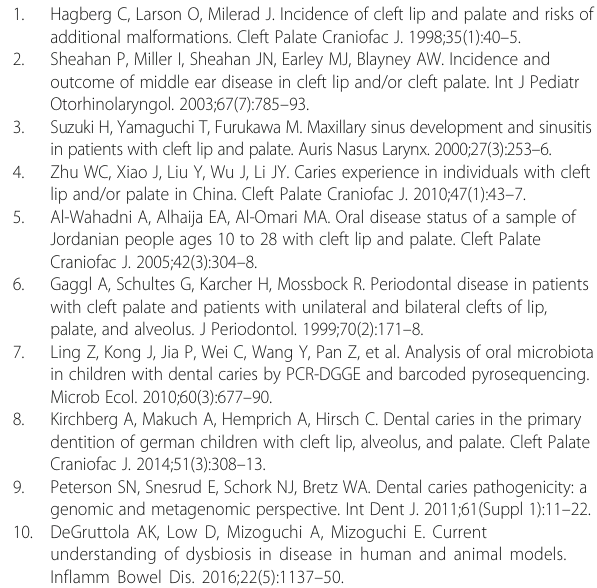
Figure S3. Scatter graphs of mRNA abundances for pairs of interacting core taxa. Figure S4. PCoA plots for the functional profiles assigned using BLASTX. Table S1. Summary of Illumina MiSeq reads and the derived data. Table S2. Rank distribution of species assigned for the rc-rRNA OTUs (relative abundance per participant). Table S3. Rank distribution of the level-1 SEED subsystem functions assigned for the mRNA reads (relative abundance per participant). Table S4. Rank distribution of the level-2 KEGG functions assigned for the mRNA reads (relative abundance per participant). Table S5. Rank distribution of the top 50 species assigned for the mRNA reads (relative abundance per participant). Table S6. Rank distribution of VTiF (mean RPKM values among the participants and the mRNA-to-rRNA ratio). Table S7. Rank distribution of the top 50 VFDB functions assigned for the mRNA reads (relative abundance per participant). Table S8. Rank distribution of the top 50 MvirDB functions assigned for the mRNA reads (relative abundance per participant). (PDF 454 kb)